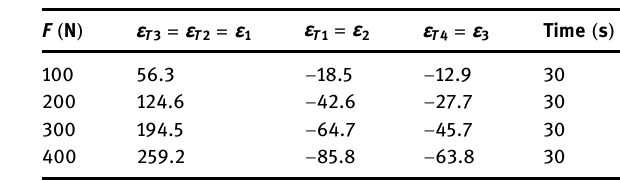
Table 3: Results of strain gauge measurements of samples K0